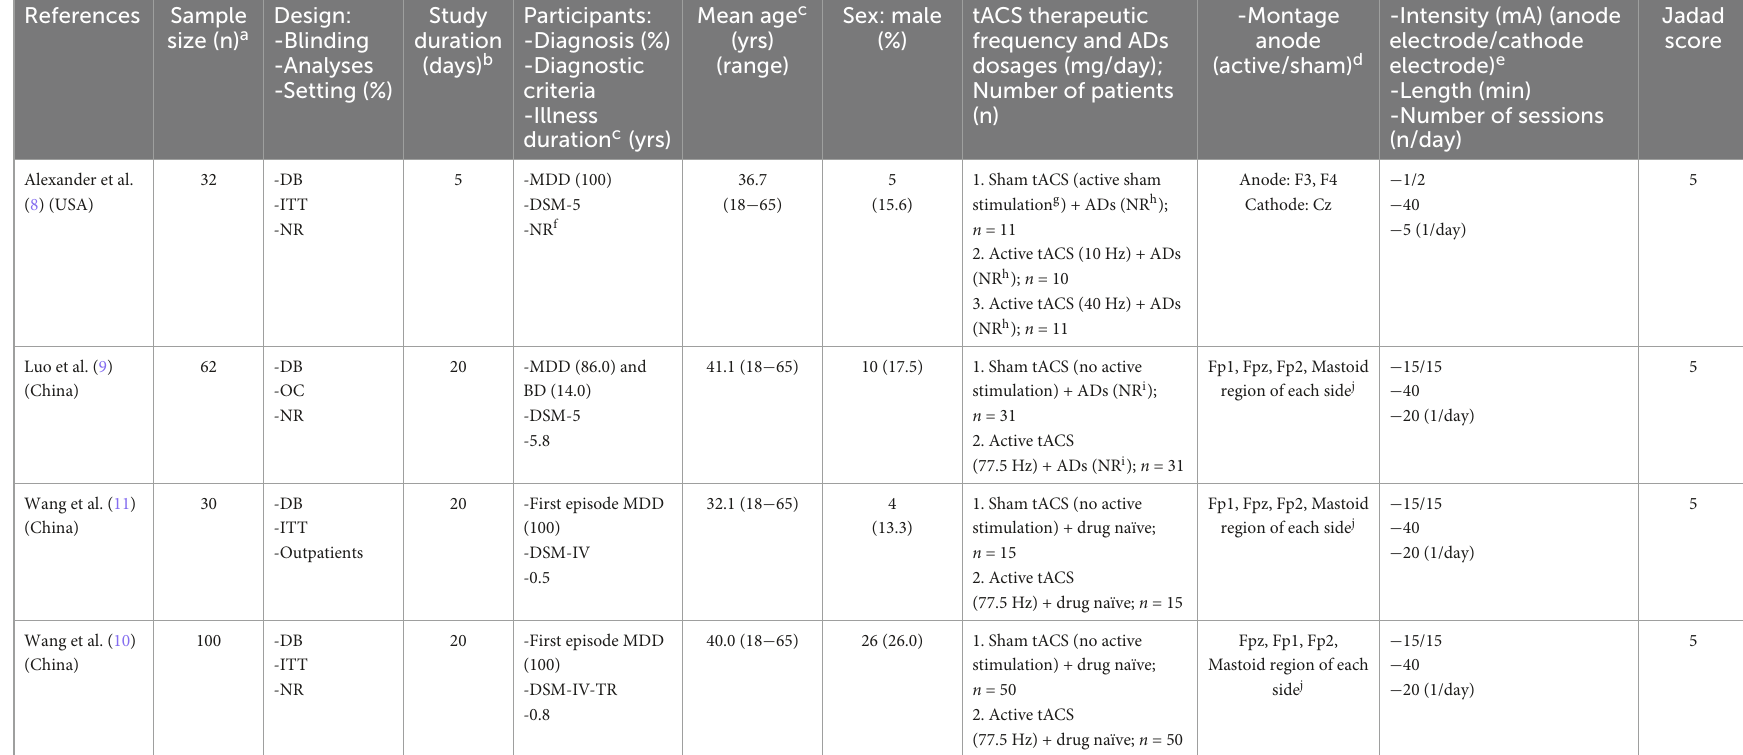
TABLE 1 Summary of studies included in this